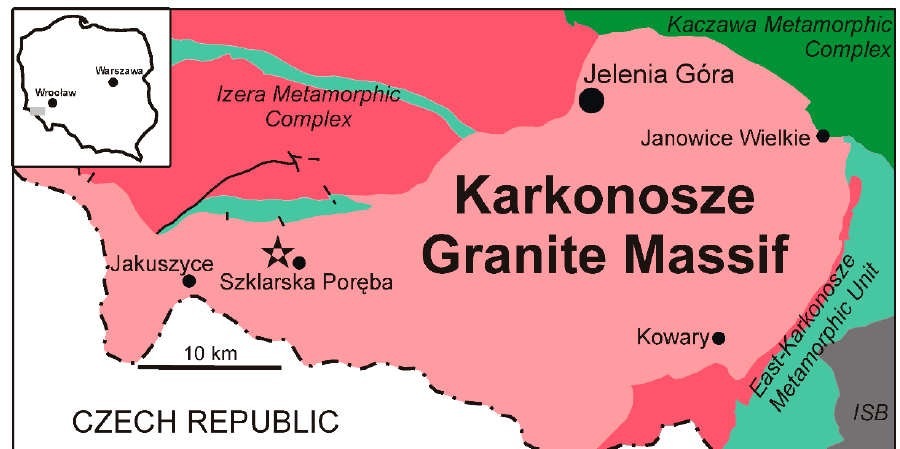
Figure 1. Geological sketch of the Polish part of the Karkonosze granite massif with its